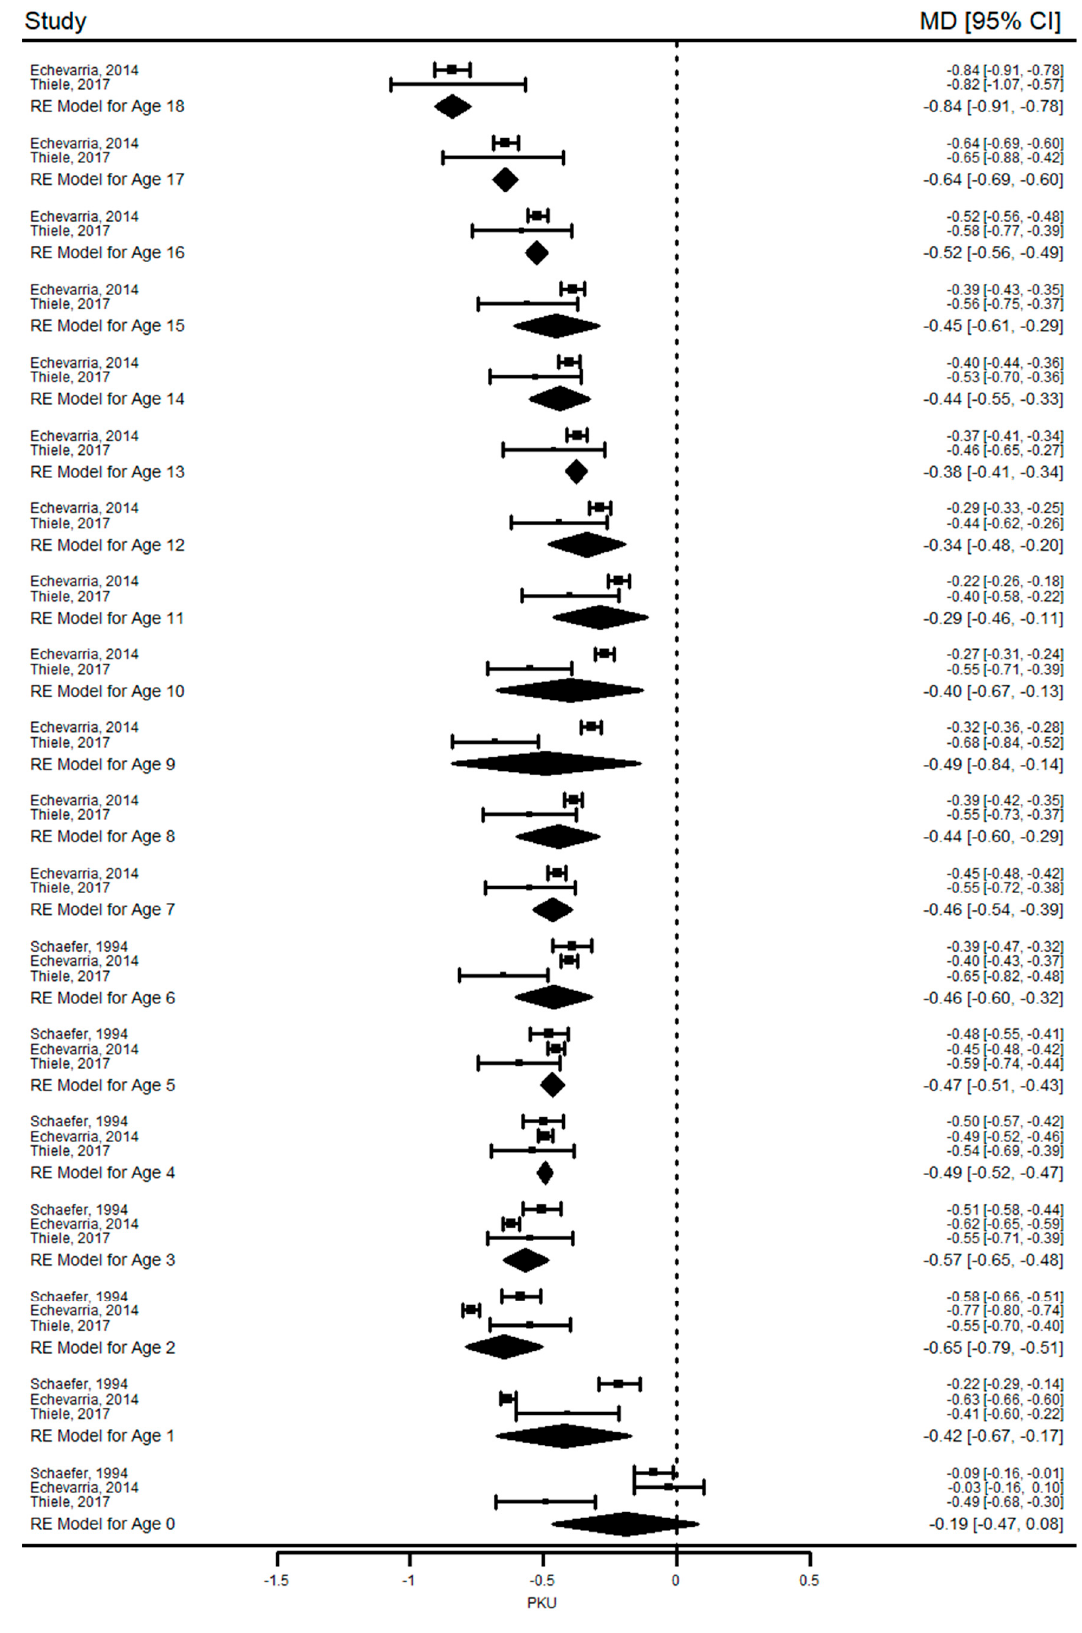
Figure 2. Comparison of mean difference height-for-age z-scores of patients with PKU compared to healthy population from birth to 18 years of age. Abbreviations: PKU: Phenylketonuria; RE: Random effects; MD: Mean difference; CI: Confidence interval.